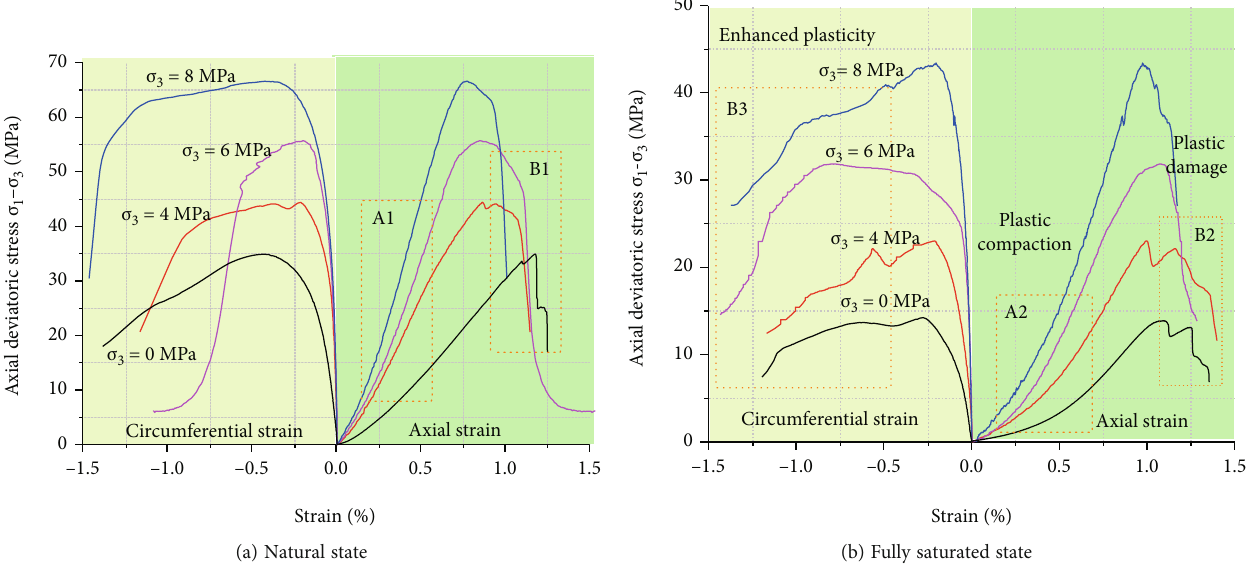
Figure 4: Relationships between the deviatoric stress and strain for natural and fully saturated rock